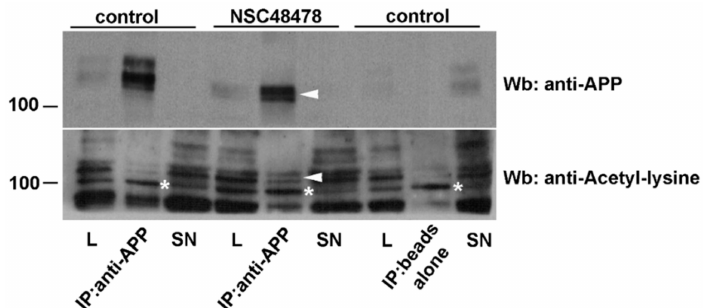
Figure 2. The immature APP isoforms accumulating under NSC48478 are acetylated. Total cell lysates were immunoprecipitated with an anti-APP antibody and then analysed for both APP (upper panel) and anti-acetylated lysine (lower panel) antibodies. Only the immature APP isoforms are acetylated (arrowheads). Beads alone indicate the negative control of the IP (immunoprecipitate). Asterisks (around 100 kDa) point to a specific band deriving from anti-acetylated lysine antibody hybridization. L: cell lysate; SN: supernatant.